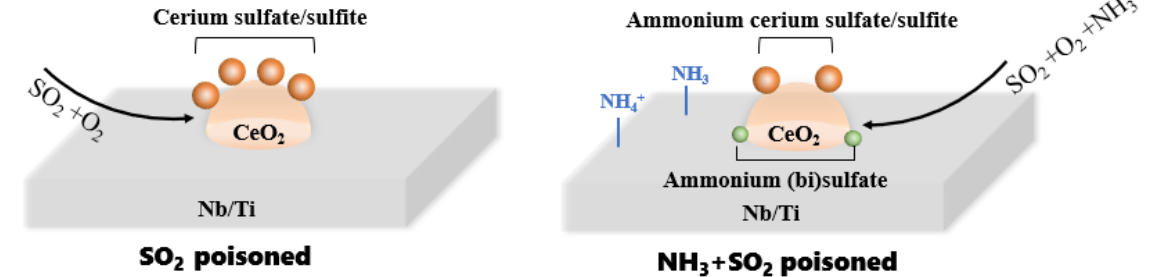
Figure 7. Schematic SO 2 deactivation mechanisms over CeNbTi in the presence and absence of NH 3 .